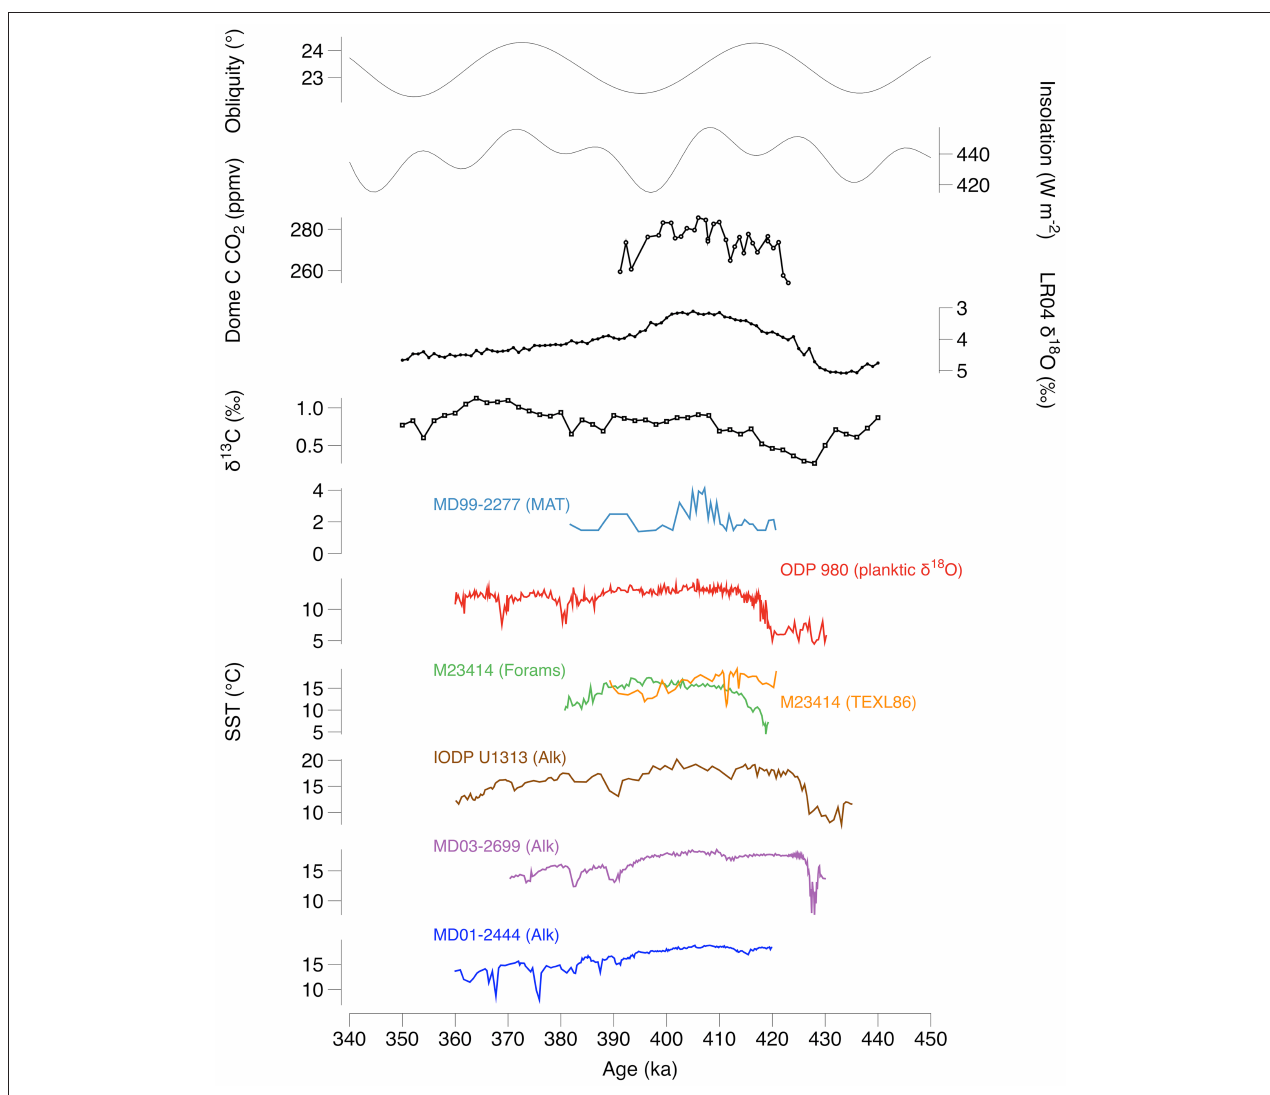
FIGURE 3 | Global signals. (Top to bottom) Orbital configurations: obliquity and mid-July insolation at 65 ◦ N (retrieved from pangaea.de; Berger and Loutre, 1991). Atmospheric CO 2 concentration derived from the EPICA Dome C ice core record (retrieved from pangaea.de; Siegenthaler et al., 2005). Lisiecki-Raymo (LR04) Global benthic stack of stable oxygen isotopes (retrieved from pangaea.de; Lisiecki and Raymo, 2005). Global stable carbon signal (retrieved from ncdc.noaa.gov; Lisiecki, 2010, 2014). Site MD99-2277 SST data calculated from modern analog technique (retrieved from pangaea.de; Kandiano et al., 2016). Site ODP 980 SST derived from planktic oxygen isotope data (retrieved from ncdc.noaa.gov; McManus et al., 1999). Site M23414 (GIK23414-8) SST data from a combined average of three methods (retrieved from pangaea.de; Kandiano and Bauch, 2007) and 0-200m TEX L 86 -derived temperature (retrieved from pangaea.de; Kandiano et al., 2017). Alkenone-derived SST for sites IODP U1313 (retrieved from pangaea.de; Stein et al., 2009), MD03-2699 (retrieved from pangaea.de; Rodrigues et al., 2011), and MD01-2444 (retrieved from pangaea.de; Martrat et al.,